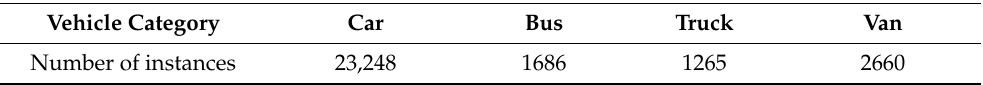
Table 1. Number of instances of different types of vehicles.